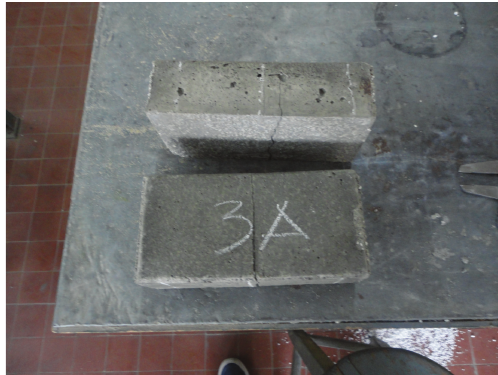
Figure 2: Resulting cracks in the brick under Tensile